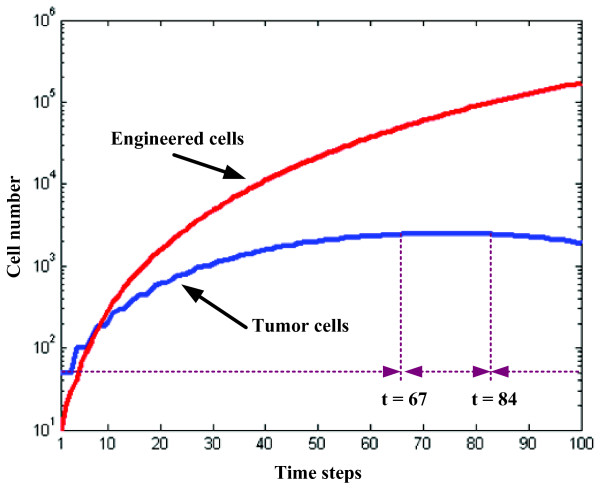
Cell number (logarithmic scale; y-axis) vs. time step (linear scale; x-axis) for a simulation with PCTC = 30 and PCEC = 67 (see Figure 5); native tumor cells are shown in blue, engineered cells in red.